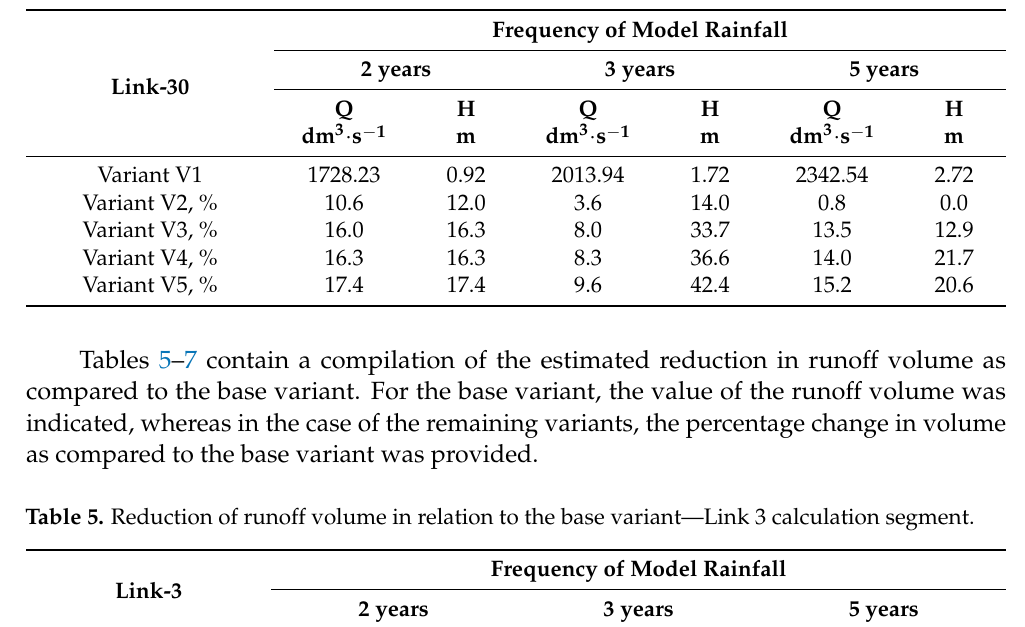
Table 4. Reduction of the maximum flow intensity and maximum depth in relation to the base variant—Link-30 calculation segment.